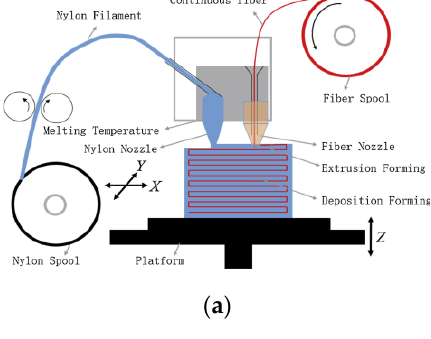
Figure 17. Printing composites by method 3 (M3): embedding on the component. ( a ) Schematic diagram Reprinted with permission from [138], 2019, Elsevier, Amsterdam, The Netherlands, ( b ) actual experimental setup-A Mark One Composite 3D printer Reprinted with permission from [81], 2017, Elsevier, Amsterdam, The